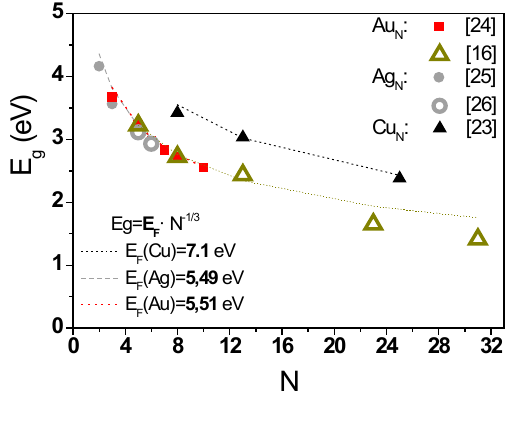
Figure 6. Data compilation corresponding to Cu, Ag and Au clusters, together with the predictions of the jellium